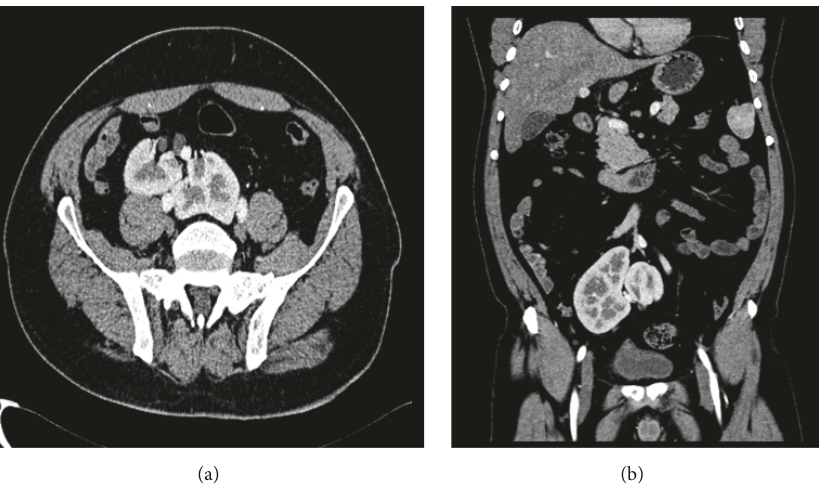
Figure 1: Axial (a) and coronal (b) CT scan, with intravenous contrast in the corticomedullary phase, showing a clear plane of separation between the two kidneys.